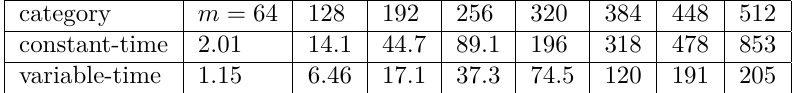
Table 15: Number of kilo cycles to evaluate the public-key with MQsoft , for m = n + v . We use a Haswell processor (ServerH) with the avx2 instructions set. Turbo Boost is not used.